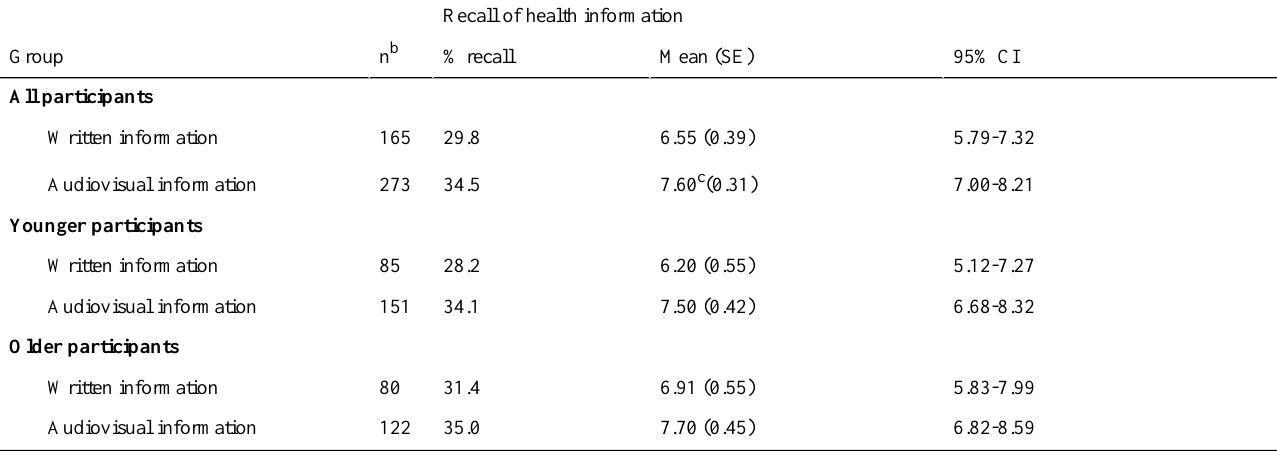
Table 2. Main effects of modality on recall of eHealth information in younger and older adults. a